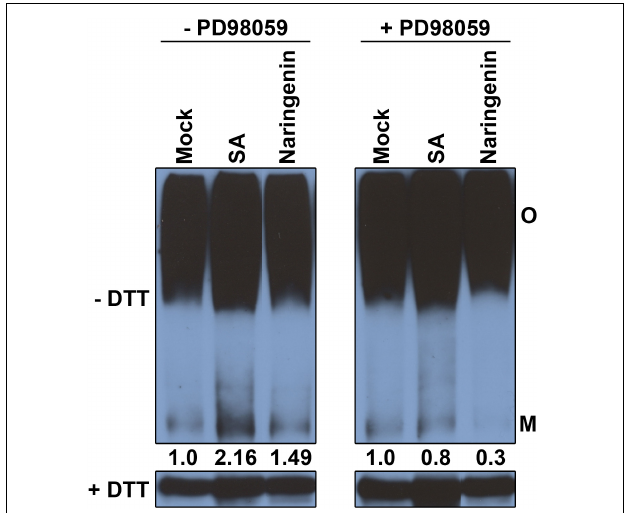
FIGURE 8 | The monomerization of NPR1 by naringenin requires MAPK activity. 35S:NPR1-GFP transgenic plants (in npr1-2 ) were pretreated with or without PD98059 (50 µ M) and then subsequently treated with 200 µ M SA or 100 µ M naringenin. Plants were collected at 4 h after treatment. Conformation of NPR1 after naringenin induction was detected by immunoblot under non-reducing conditions. Total protein (30 µ g) was extracted and subjected to SDS-PAGE with or without DTT in the sample buffer (62.5 mM Tris-HCl pH 6.8, 10% glycerol, 1% LDS, and 0.005% Bromophenol Blue) and analyzed using immunoblot using polyclonal anti-NPR1 antibodies. Both oligomeric (O) and monomeric (M) forms of NPR1-GFP were detected. The experiment was repeated three times with similar results.